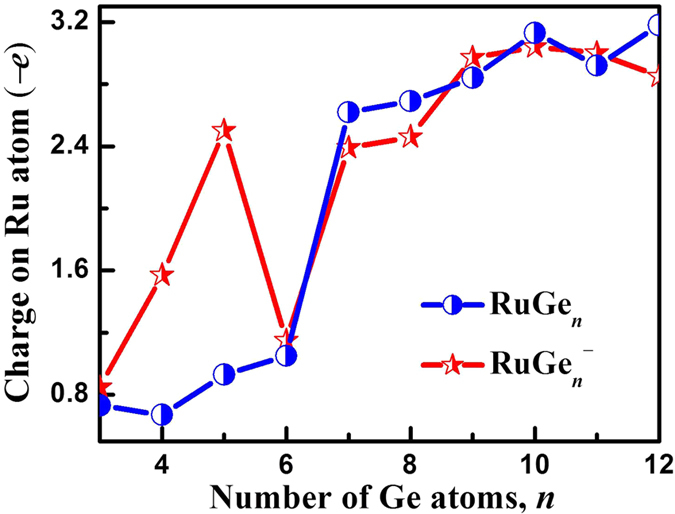
Natural charge populations of the Ru atom for the global minimum structures of RuGen−/0 (n = 3–12) clusters.